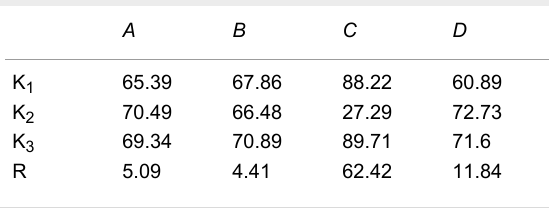
Table 2: Range analysis of orthogonal experimental